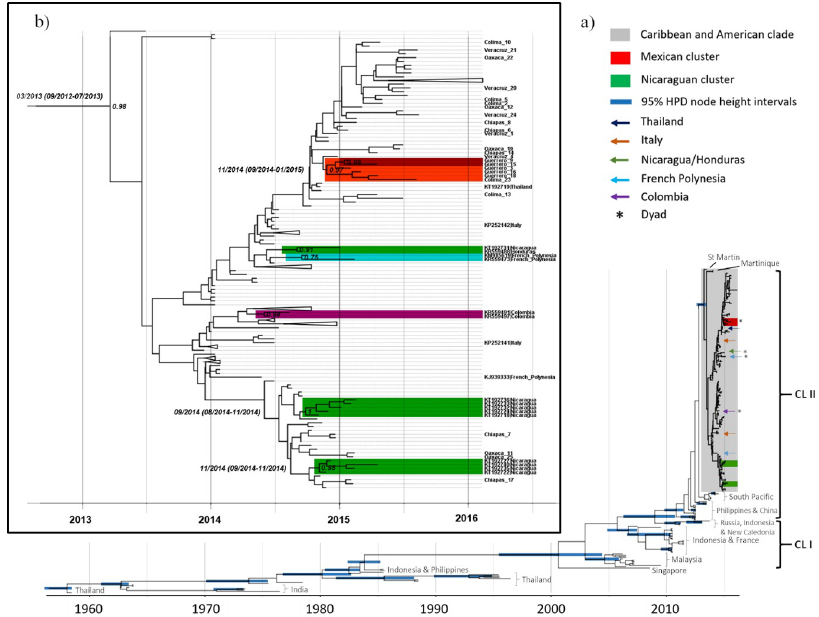
Fig 3. Bayesian phylogenetic analysis of partial CHIKV E1 gene sequences. (A) Bayesian MCC tree of 249 Asian lineage strains calibrated to the sampling date and built using the HKY+G nucleotide substitution model, a lognormal relaxed clock and a Bayesian Skygrid coalescent model. Nodes with posterior probabilities (clade-credibility values) � 0.9 have 95% HPD intervals for node heights shown. The two main epidemic Asian lineage clades (CL) are also shown. (B) A subtree of the American and Caribbean sublineage showing posterior probabilities and calibrated tMRCA and 95% HPD intervals for statistically supported monophyletic groups. For clarity, node bars with 95% HPD intervals are not shown, only relevant strains are labelled, and the colour code is as in section